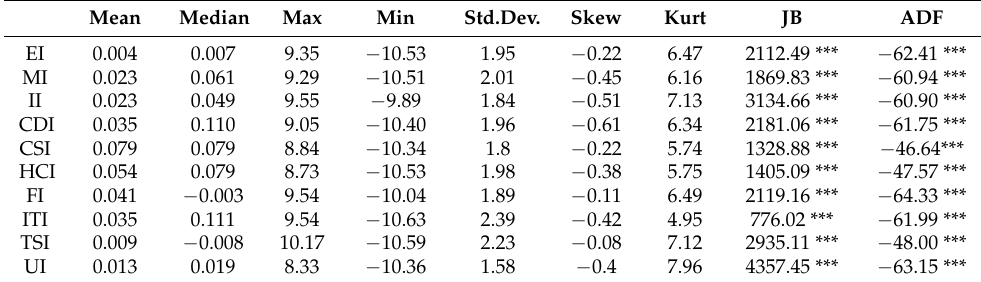
Table 1. Descriptive statistics of 10 sector indices’ yield 1